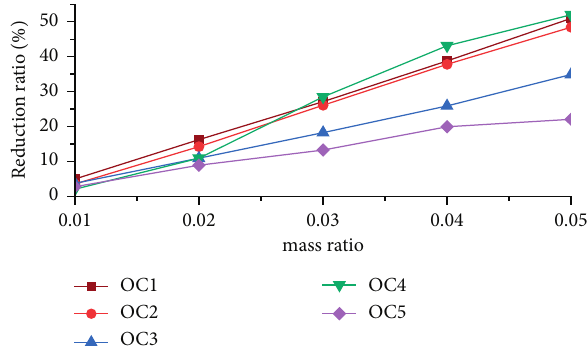
Figure 14: : Acceleration reduction ratio of PTMDs of mass ratio from 1% to 5%.